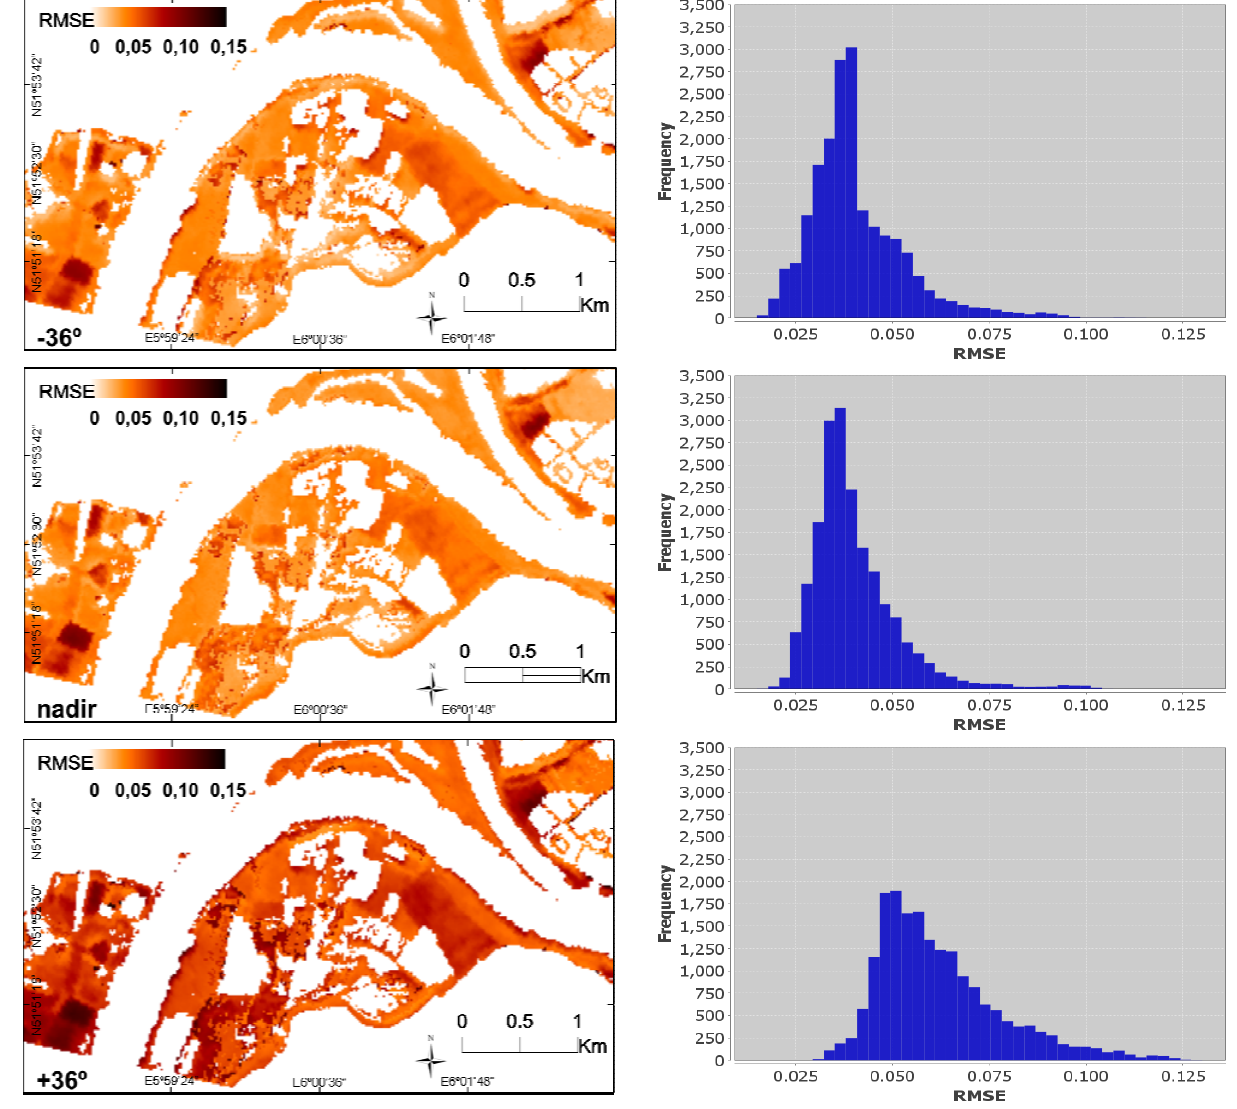
Figure 6. Maps of minimum RMSEs for LAI retrievals ( left ) and derived histograms for <8.5 ( right ) of Millingerwaard for the backward scattering direction ( − 36° VZA) ( top ), the nadir direction ( middle ) and the forward scattering direction (+36° VZA) ( down ), derived with FLIGHT model